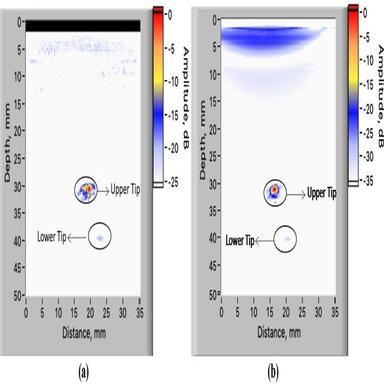
Processed B-scan images for 20 inclined slot in 60 mm thick stainless steel plate (a) PA-SAFT and (b) FMC + TFM.